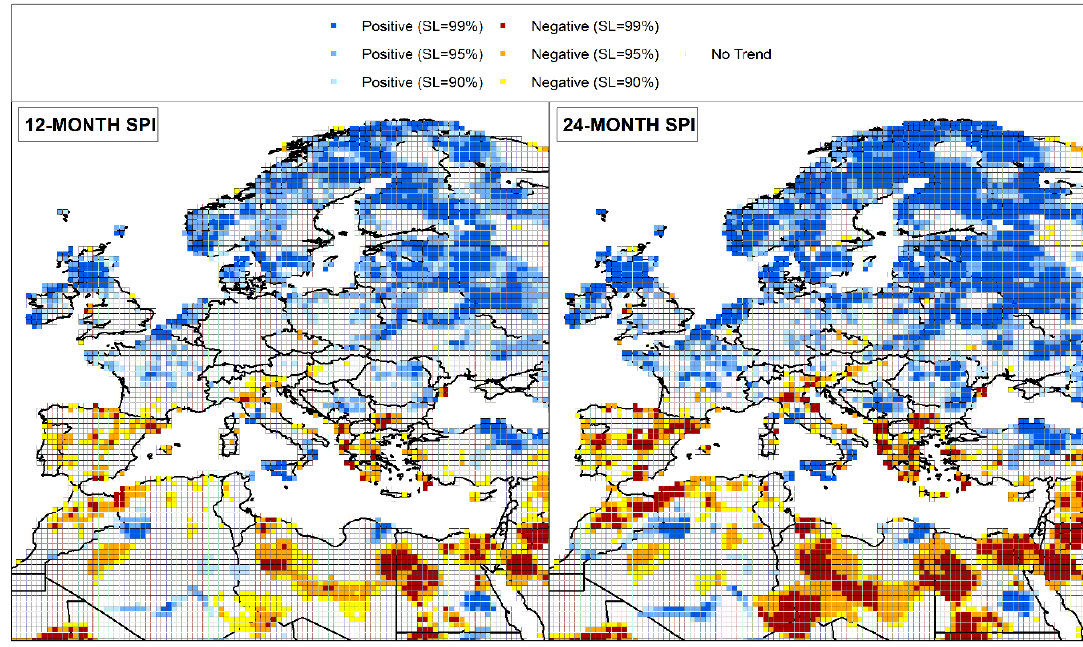
Figure 5. Spatial distribution of the grid points presenting positive or negative rainfall trends (annual scale). Colored squares indicate significant positive or negative trends while white squares refer to a non-significant trend.